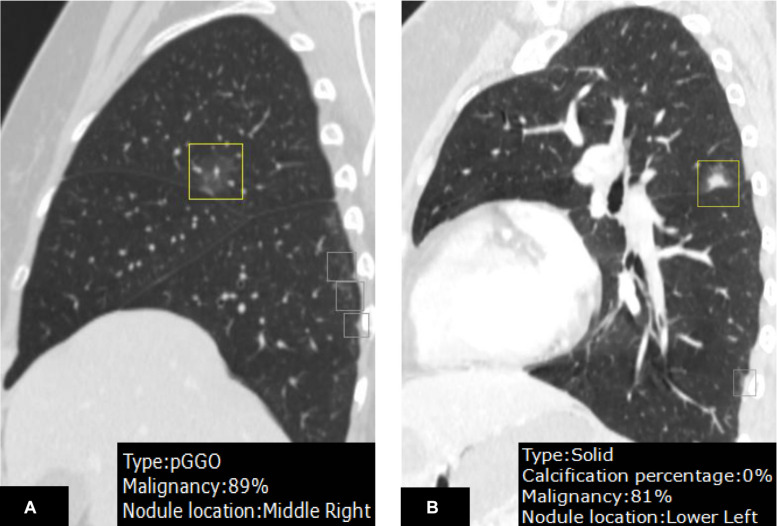
A juxtafissural nodule (A) located in the right upper lobe was mislabeled by DL-CADx as right middle lobe. Another nodule (B) attached to the fissure in the left upper lobe was mis-localized in the left lower lobe by DL-CADx.